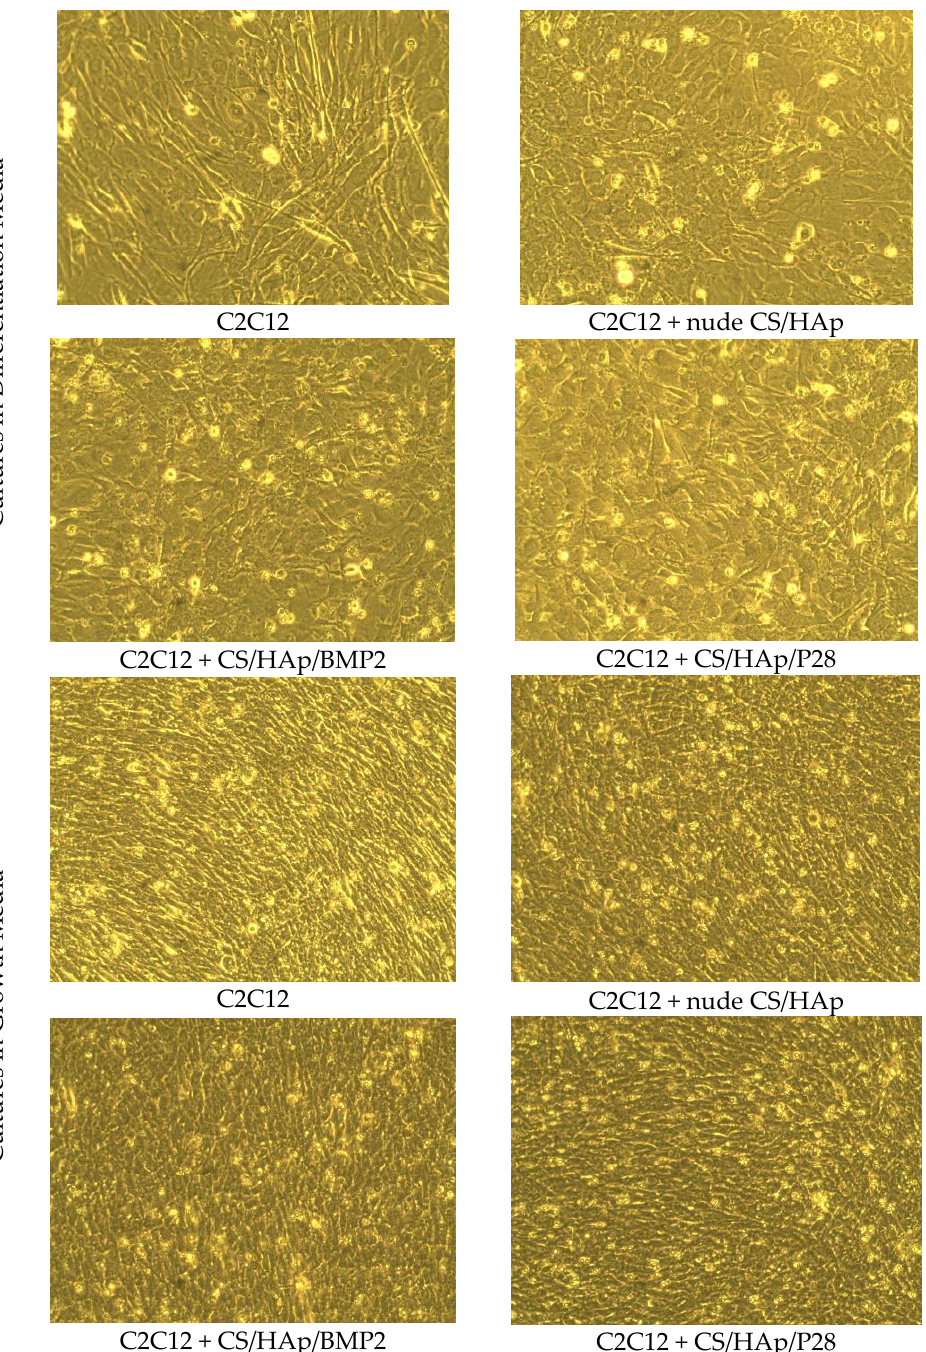
Figure 4. Morphological changes in C2C12 following cultured with the various scaffold formulations in differentiation media (magnification: 10 × ) and growth media (magnification: 4 × ). Cuboidal morphology can be observed in the culture with CS/HAp/BMP-2 and CS/HAp/P28 compared to the controls.